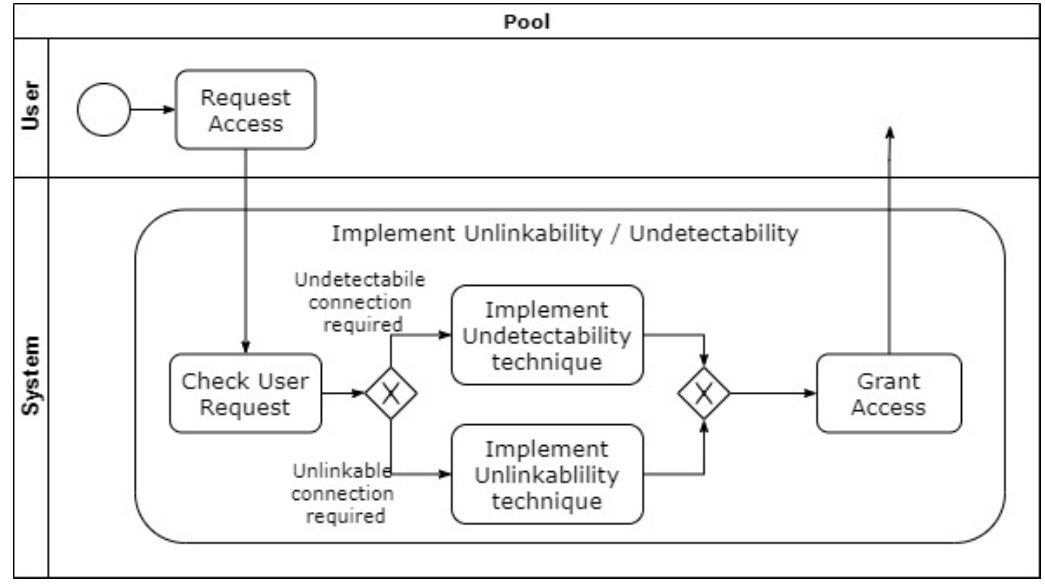
Figure 21. Conceptual overview of Unlinkability and Undetectability process pattern [49].